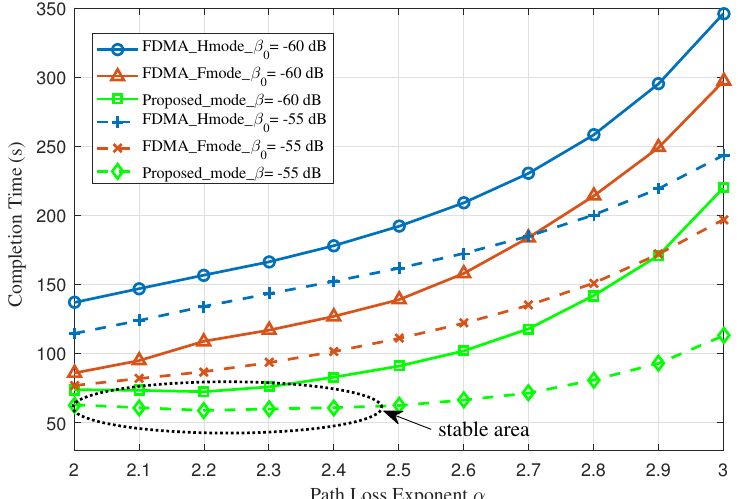
Figure 9. Optimal resource allocation over different time slots for multiple UAVs in the general scenario: ( a ) The optimal resource allocation over the time slots in the first half of the total duration; ( b ) the optimal resource allocation over the time slots in the second half of the total duration.